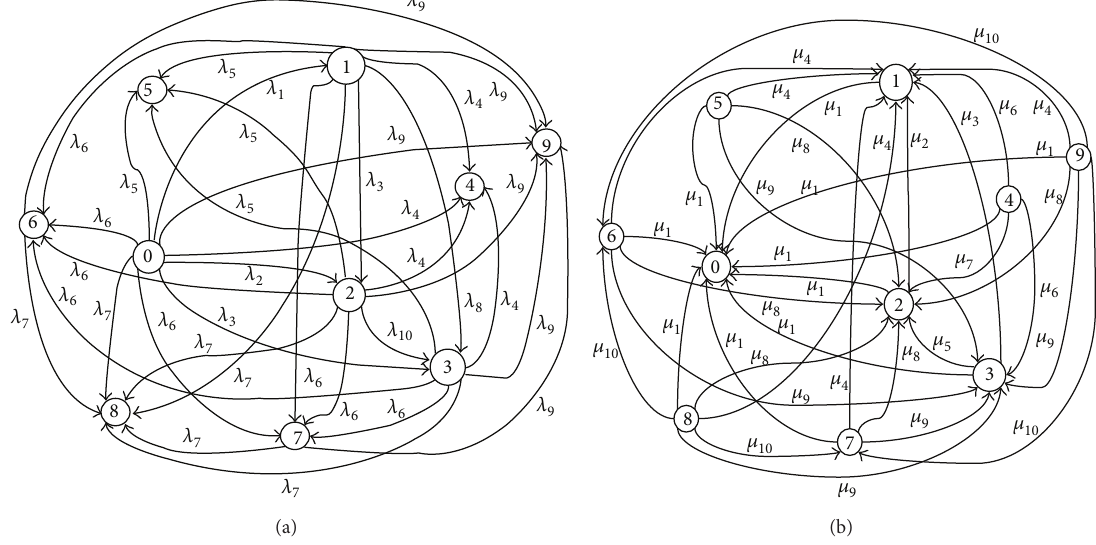
Figure 8: Markov model of VLWBC algorithm with determination of (a) failure rate ( 𝜆 ) and (b) repair rate ( 𝜇 ) in each path.